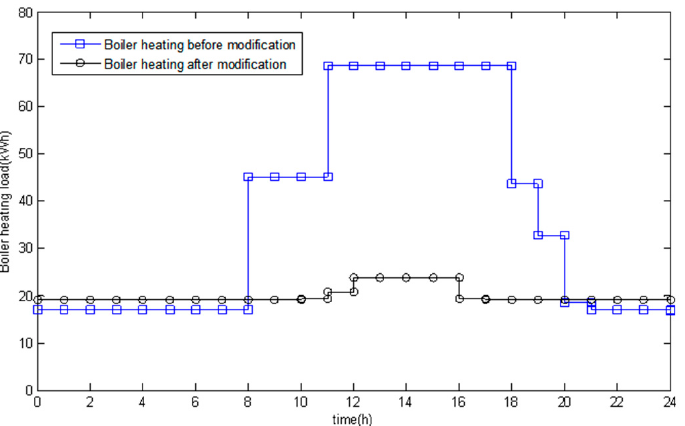
Figure 13. Output heat of the electric heating boiler.